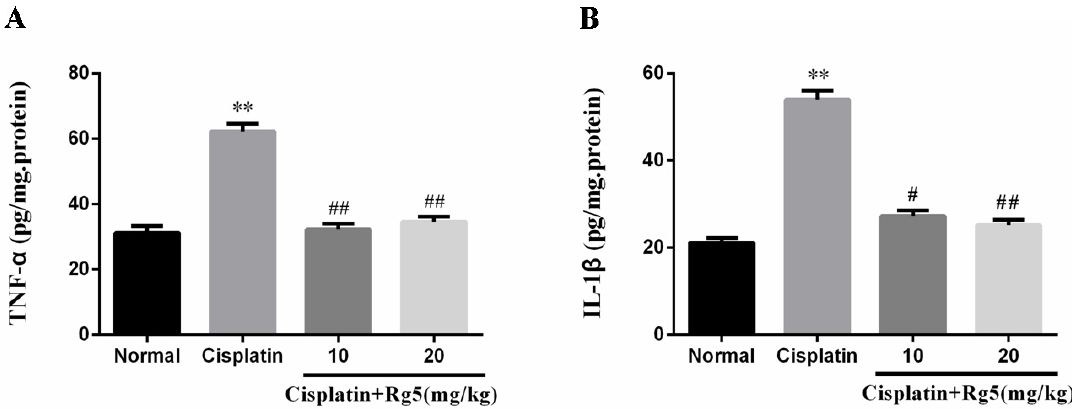
Figure 6. Effect of Rg5 on the levels of renal inflammatory cytokines in cisplatin-induced nephrotoxicity.